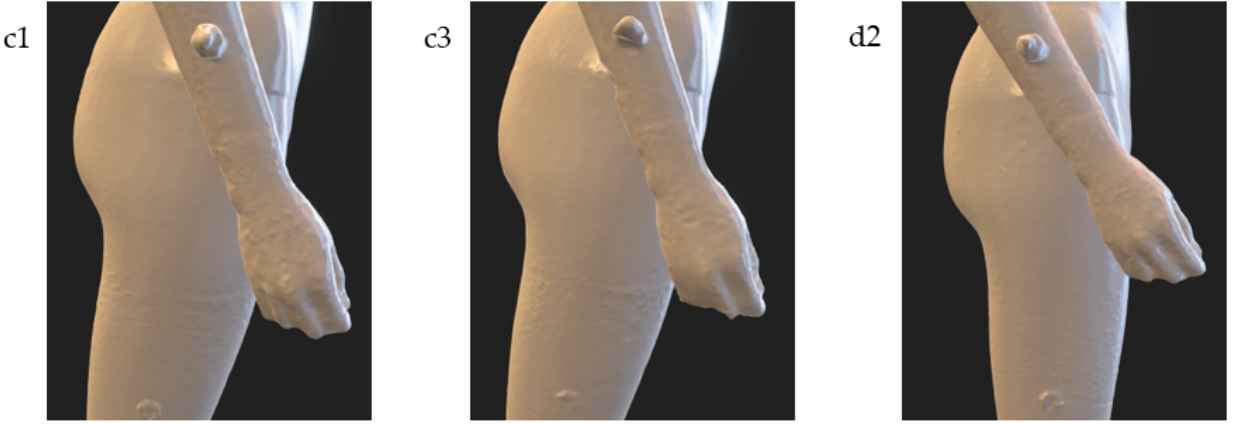
Figure 16. The illustration of reconstruction accuracy of hand for selected experimental tests of the HUBO scanner.